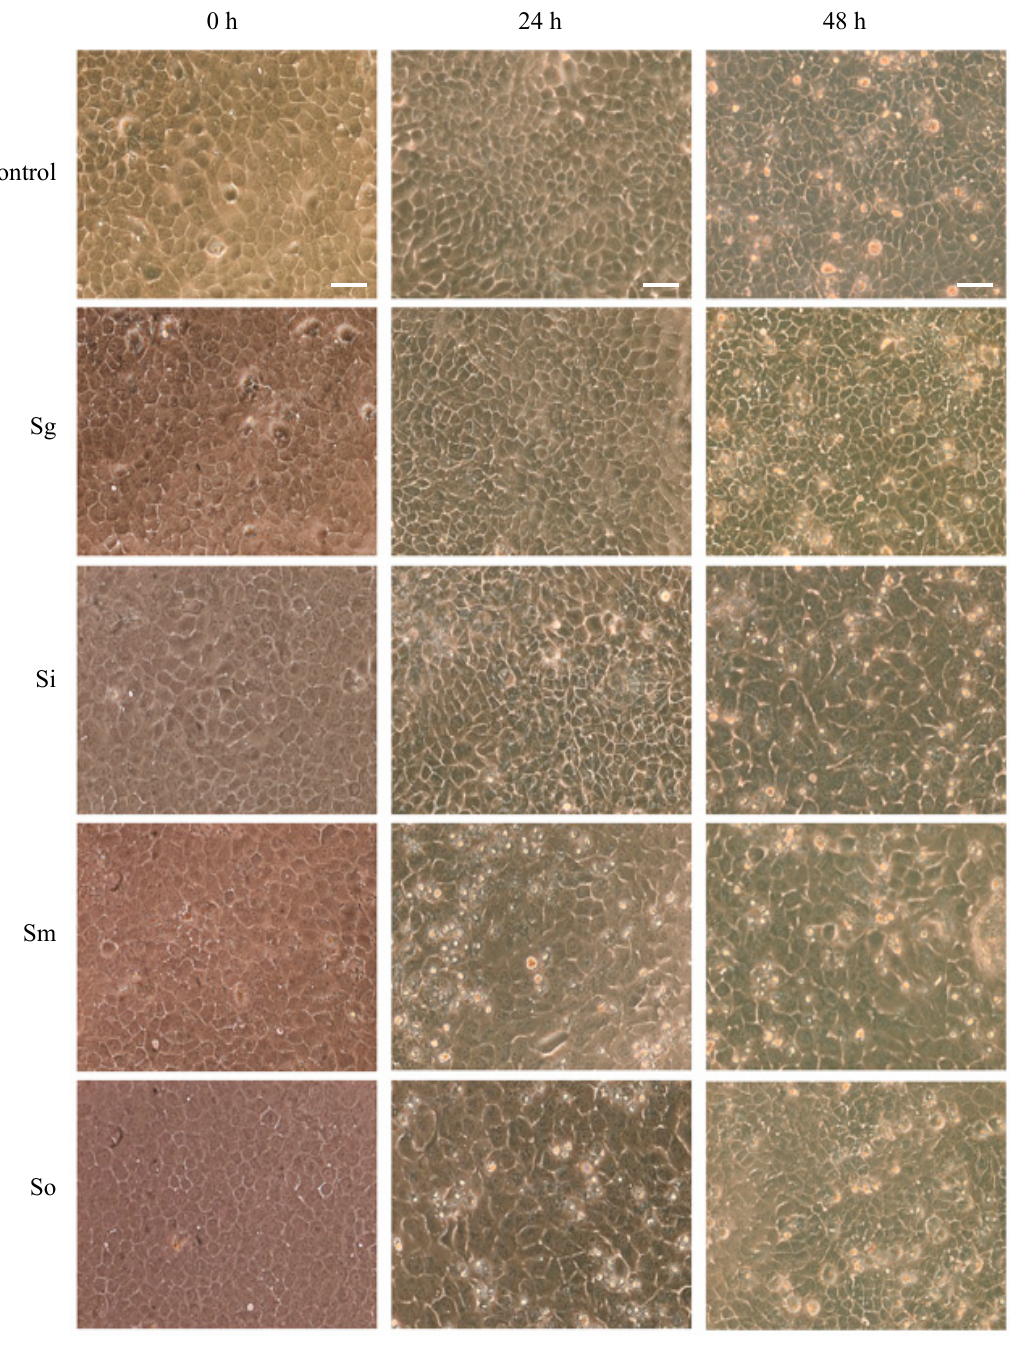
Figure 2. OKF6/Tert cellular morphology after exposure to S. gordonii (Sg), S. intermedius (Si), S. mitis (Sm), and S. oralis (So) at MOI = 100 for 1 h of interaction. Light microscopy images were obtained at a magnification of 200X. Bars = 100 μ m. Representative images from three independent experiments.